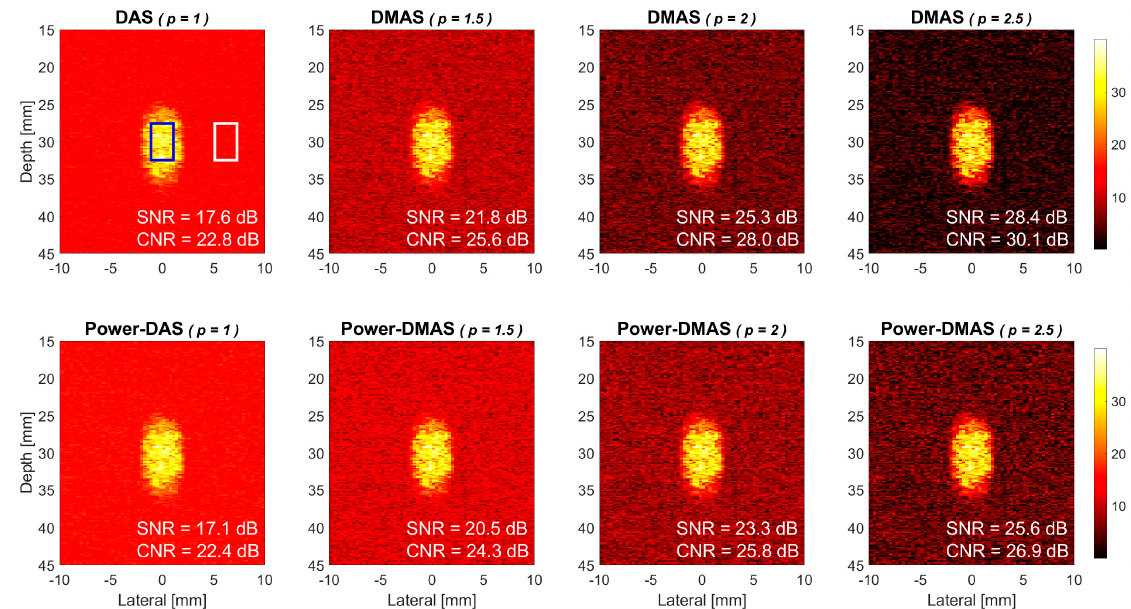
Figure 8. Simulated power Doppler images of flow phantom for DAS beamforming, DMAS beamforming with the p value of 1.5, 2.0, and 2.5, respectively, from left to right. Seven PW transmit angles are used (i.e., [ − 7.5° − 5° − 2.5° 0° +2.5° +5° +7.5°]). Upper panels: ensemble averaging of signal magnitude. Lower panels: ensemble averaging of signal power.